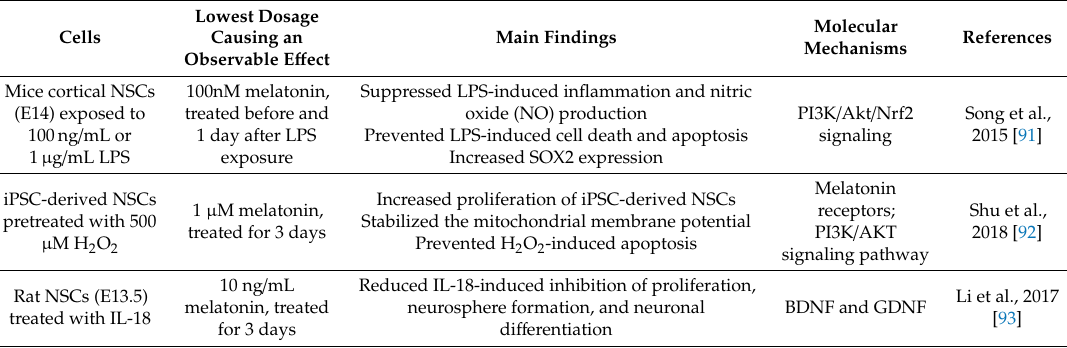
Table 9. Table showing the main findings regarding the e ff ects of melatonin on neurogenesis in inflammation and oxidative stress and the respective molecular mechanisms in the in vitro studies. Lowest Dosage Molecular Cells Causing an Main Findings Observable E ff ect